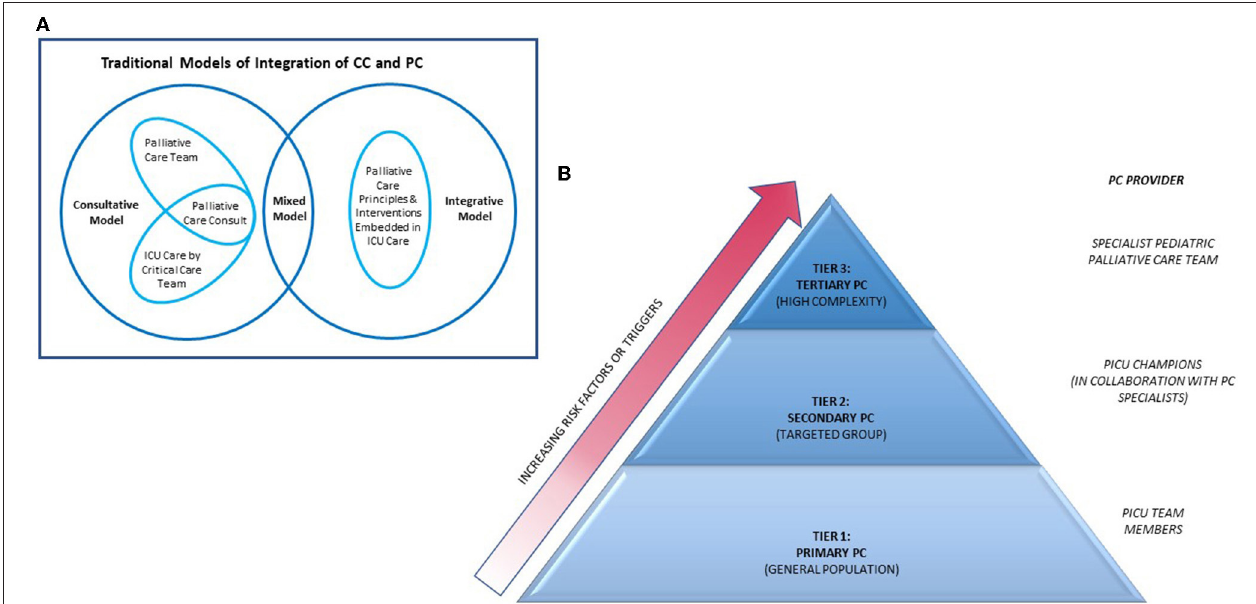
FIGURE 1 | Models of integration of PC into ICU. PC, palliative care; CC, critical care; ICU, intensive care unit. (A) Diagram depicting interactions of traditional models of integration of PC into ICU. Adapted from Nelson et al. (64). (B) Pyramid model of integrating of PC into ICU. Source—Public domain and adapted from Rothschild et al. (